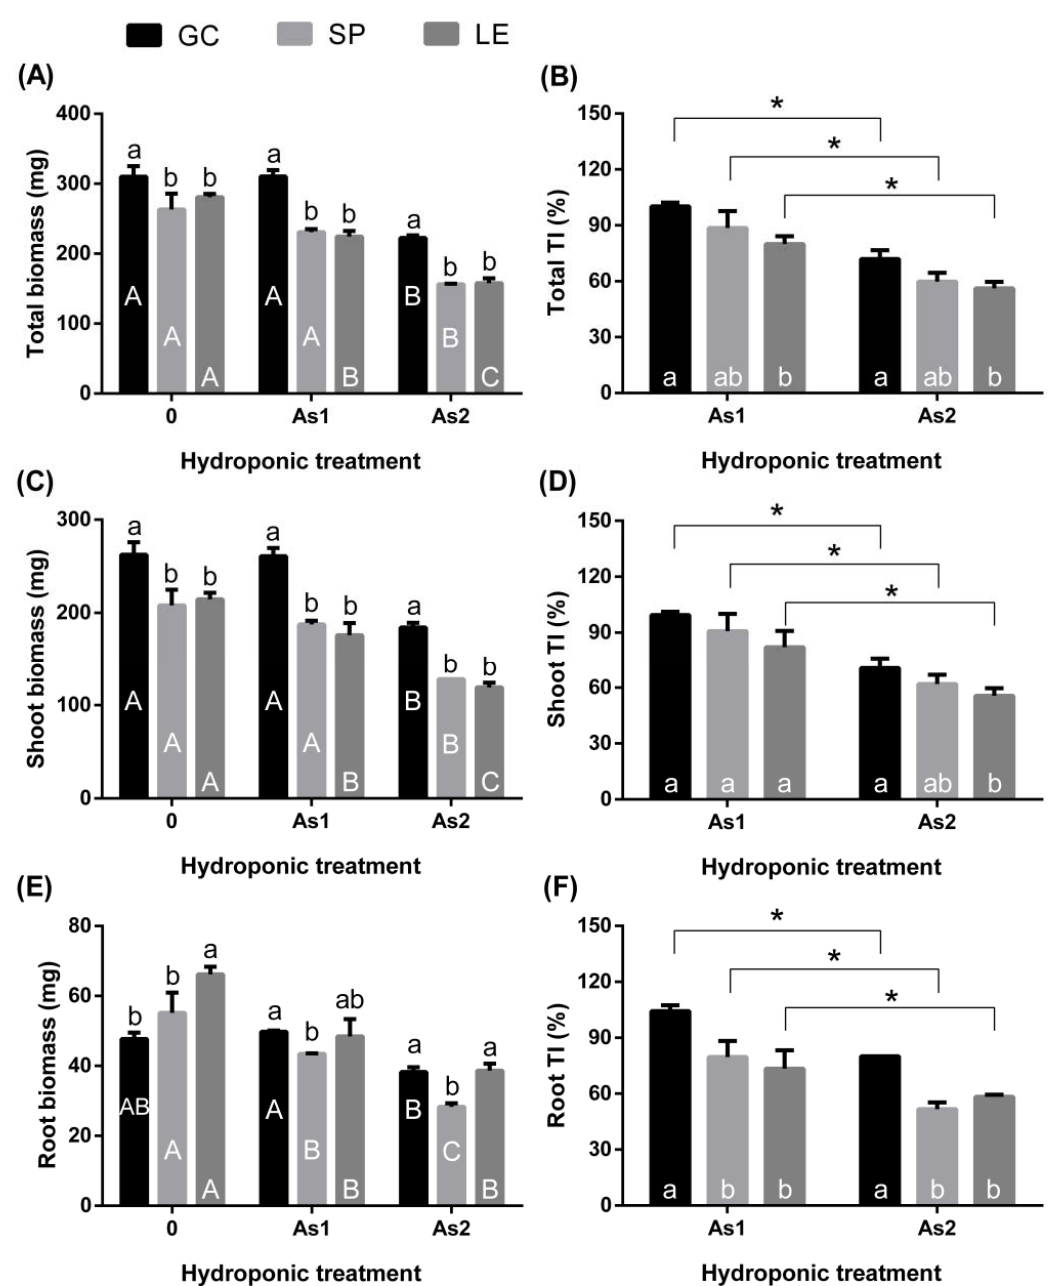
Figure 2. Biomass ( A , C , E ) of GC, SP, and LE and the TI of the plants to As in the hydroponic test ( B , D , F ). Note: Different lowercase letters in the figure indicate comparisons between different vegetables under the same treatment; different uppercase letters indicate the comparison of the same vegetable under different treatments (5% levels). The symbol * indicates that the difference in values between As1 and As2 was significant at the respective 5% levels. The error bars in the graph indicate the SEM (standard error of the mean).